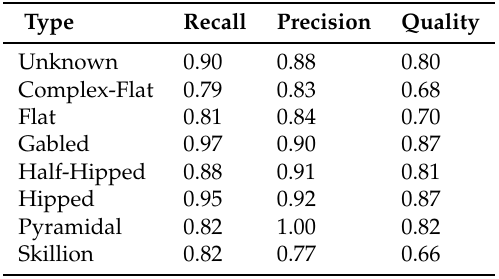
Table 7. Results for recall, precision, and quality evaluation metrics for Test Set 1.